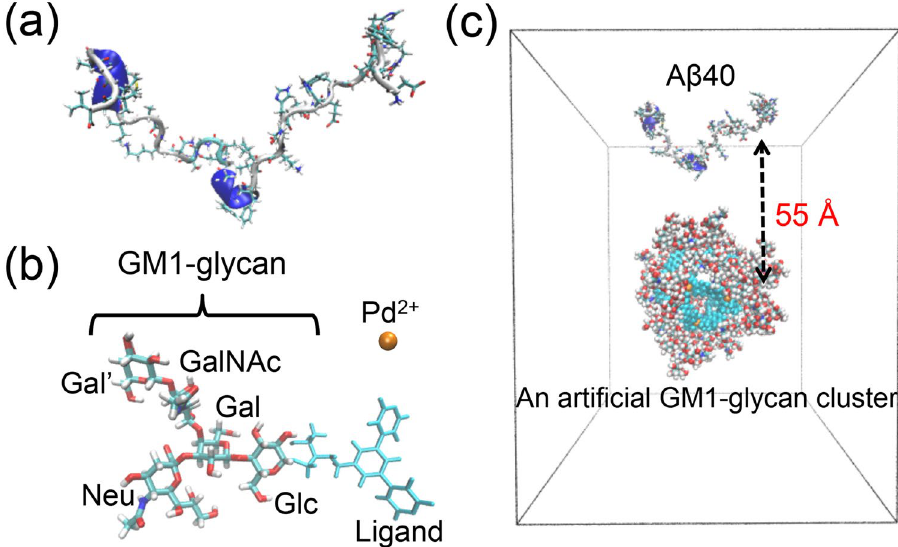
Figure 1. ( a ) An initial conformation of A β 40 for binding to the GM1-glycan. ( b ) Structures of ligand with GM1-glycan and palladium ion. Ligand was introduced to connect to Glc of GM1-glycan instead of the lipid ceramide moiety 24 . ( c ) An initial position of A β 40 and an artificial GM1-glycan